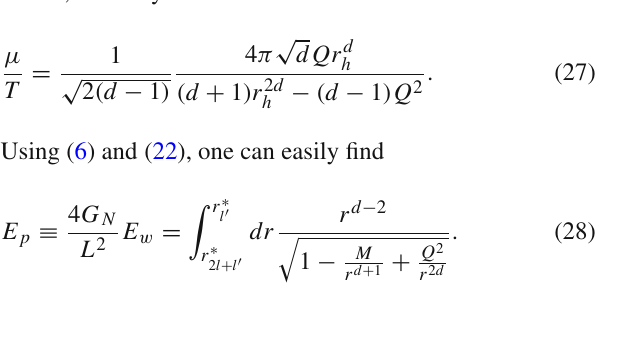
, with respect to μ for T 2